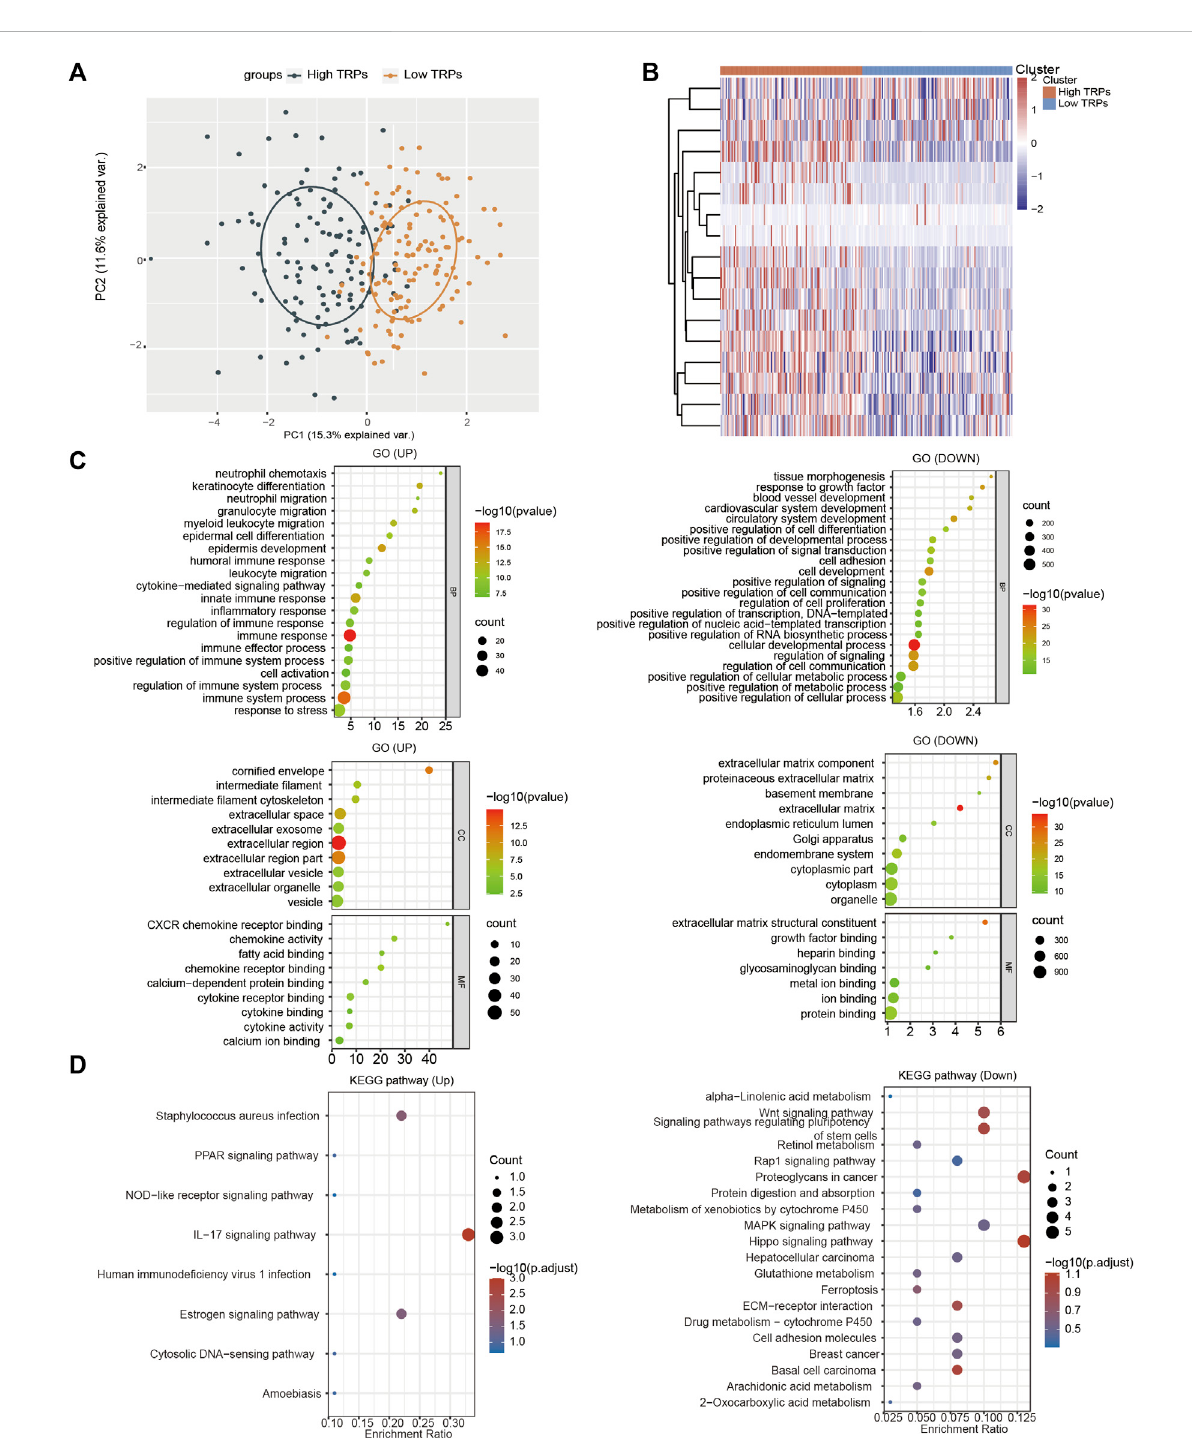
Functional analysisofTRPsfamilyinCSCC. (A) PCAanalysisbasedon theexpressionlevelsofTRPs. (B) Heatmapshow thehigh expressed TRPs and low expressed TRPs in two clusters. (C,D) The GO analysis and KEGG (Kyoto Encyclopedia of Genes and Genomes) analysis were performed on TRPs, and the correlation was evaluated with the enrichment